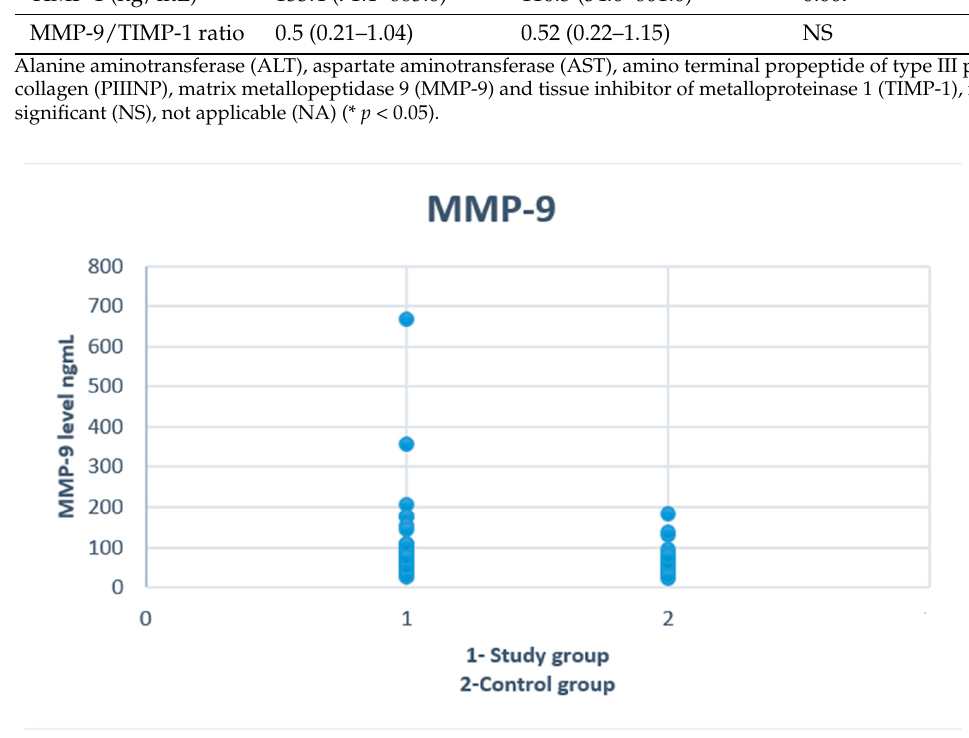
Figure 1. Serum concentrations of MMP-9 in study and control groups.